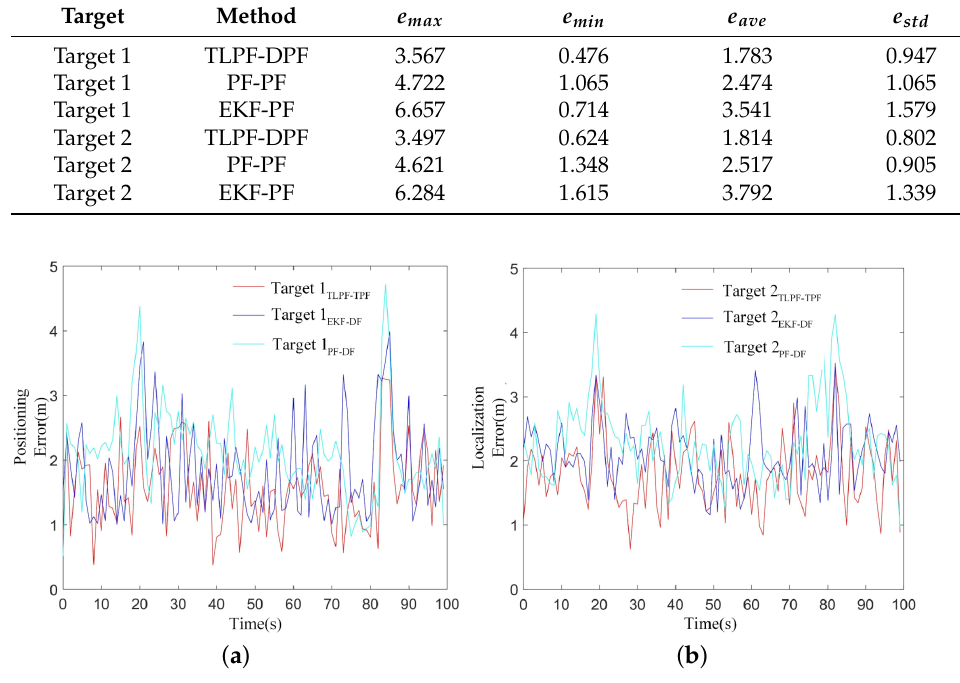
Figure 7. Targets’ Tracking Error Under Gaussian Noise. ( a ) Target 1’s Positioning Error under Gaussian Noise. ( b ) Target 2’s Positioning Error under Gaussian Noise.